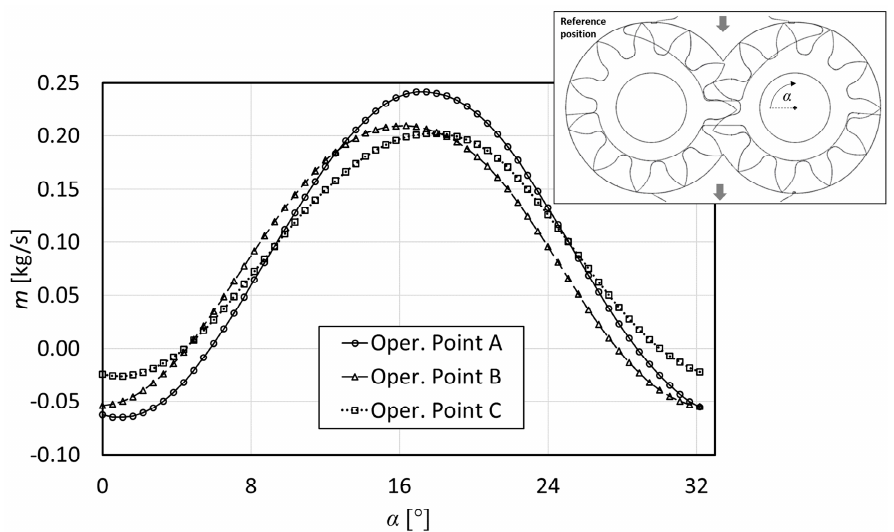
Figure 16. Mass flow rate trends according to the angular position of the wheel (see reference position) as a function of the three different operating conditions.